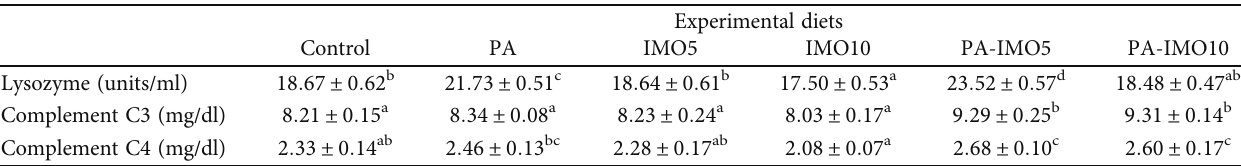
Table 3: Blood immune parameters of common carp fed di ff erent levels of Pediococcus acidilactici (PA) and isomaltooligosaccharide (IMO) after 8 weeks.